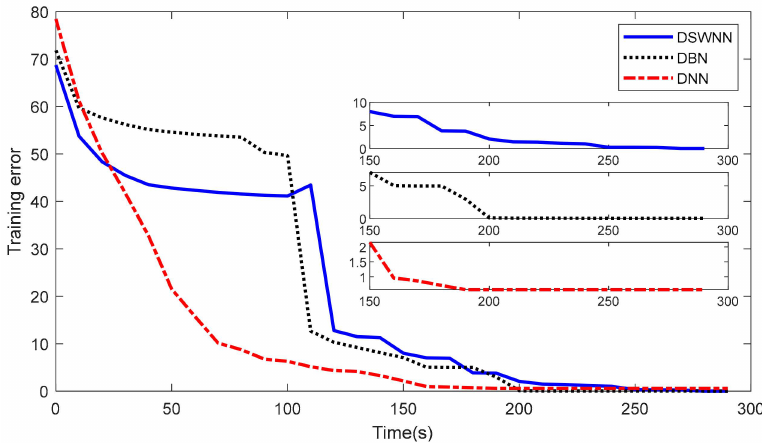
Figure 9. Training errors of the DSWNN, DBN, and